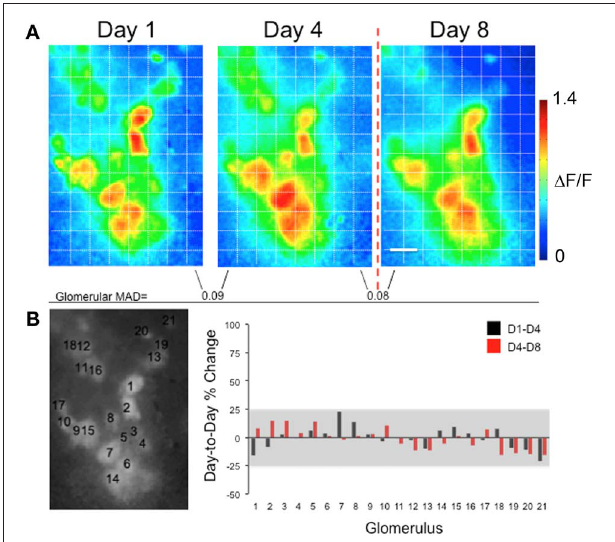
FIGURE 5 | Changes in glomerular G-CaMP2 responses following associative conditioning in individual mice. (A) Methyl valerate response maps taken from the same animal across several days. Maps from Day 1 to Day 4 were taken prior to any conditioning and were similar across the days. The last map (Day 8) was taken one day after exposing the animal to presentation of methyl valerate paired with foot shock. Unlike the control days, large changes in response amplitude were seen in a few glomeruli following the training (white arrows). The Mean Absolute Day-to-Day Difference (MAD) for each glomerulus increased after training. Scale bar: 100 μ m (B) The left panel indicates the position of the glomeruli. The graph represents the percent change in response for each glomerulus across days. The gray box represents the pre-training percent change (mean ± 2SD) taken from all glomeruli across all three groups. Large increases in response amplitude can be seen for glomeruli #1 and #8.